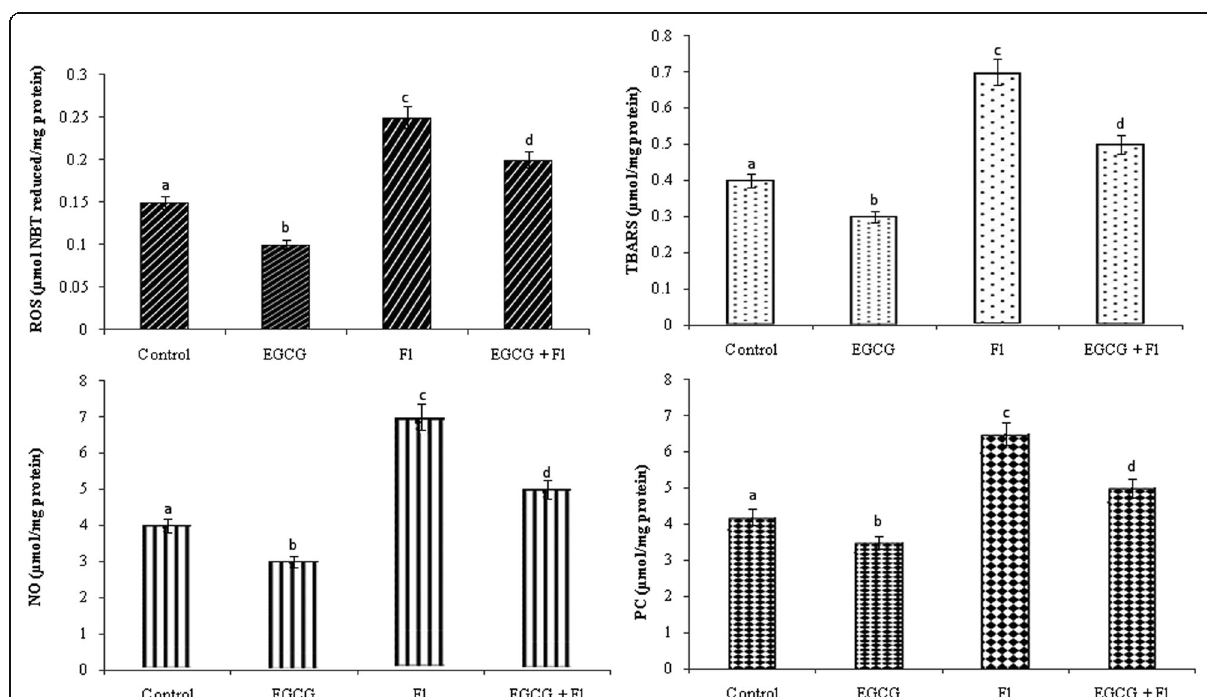
Fig. 4 Effect of EGCG on the ROS, TBARS, NO, and PC in the hippocampus of control and experimental rats. Values are mean ± SD for 6 rats in each group. a, b, c, d Values not sharing a common superscript letter (a, b, and c) differ significantly at p < 0.05